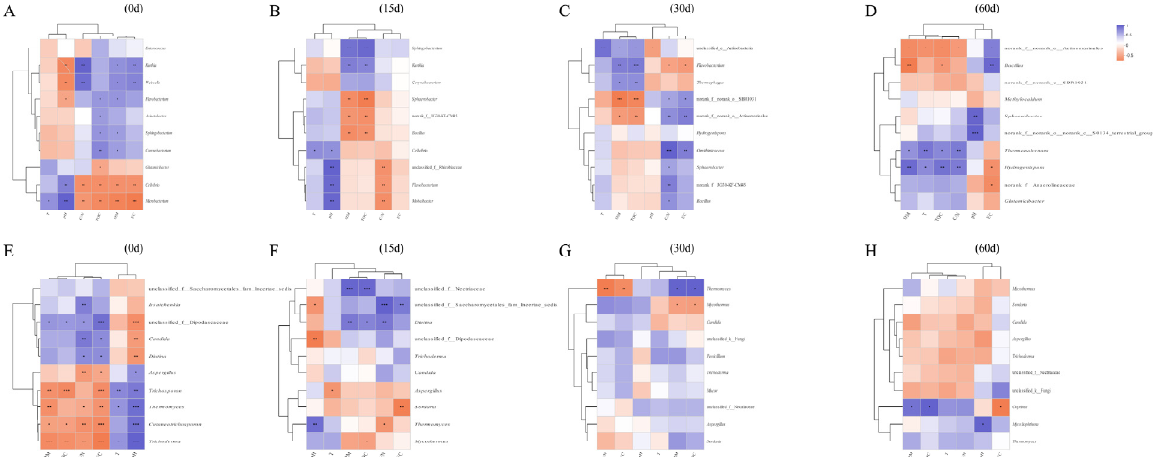
Figure 6. Spearman’s correlation heatmaps of the abundance of the top 10 enriched bacteria and fungi at the genus level with physical and chemical properties during the composting process. Bac- teria: 0 d ( A ), 15 d ( B ), 30 d ( C ), and 60 d ( D ) of composting. Fungi: 0 d ( E ), 15 d ( F ), 30 d ( G ), and 60 d ( H ) of composting. The X and Y axes are environmental factors and genus, respectively. Blue in- dicates a positive correlation, whereas orange indicates a negative correlation. B1, V mushroom res- idue: V sheep manure = 5:1, with CMA inoculation; B2, V mushroom residue: V sheep manure = 5:1, without inoculation; T1, V mushroom residue: V sheep manure = 9:1, with CMA inoculation; T2, V mushroom residue: V sheep manure = 9:1, without inoculation. *, p ≤ 0.05; **, p ≤ 0.01; ***, p ≤ 0.001.